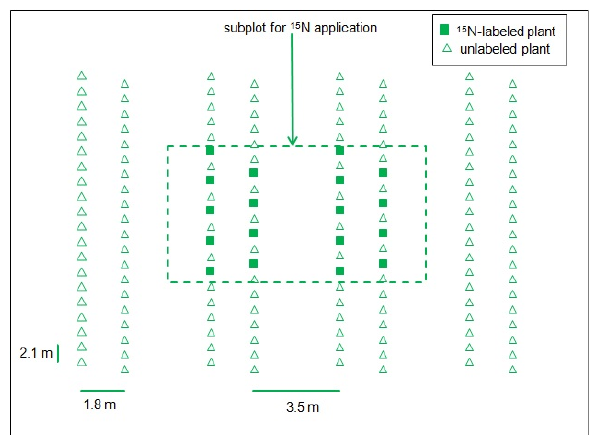
Figure 1. Example of the experimental plot of banana crop including a subplot for 15 N application. The same design was applied to both the GS1 (first growing season) and GS4 (fourth growing season) treatments.